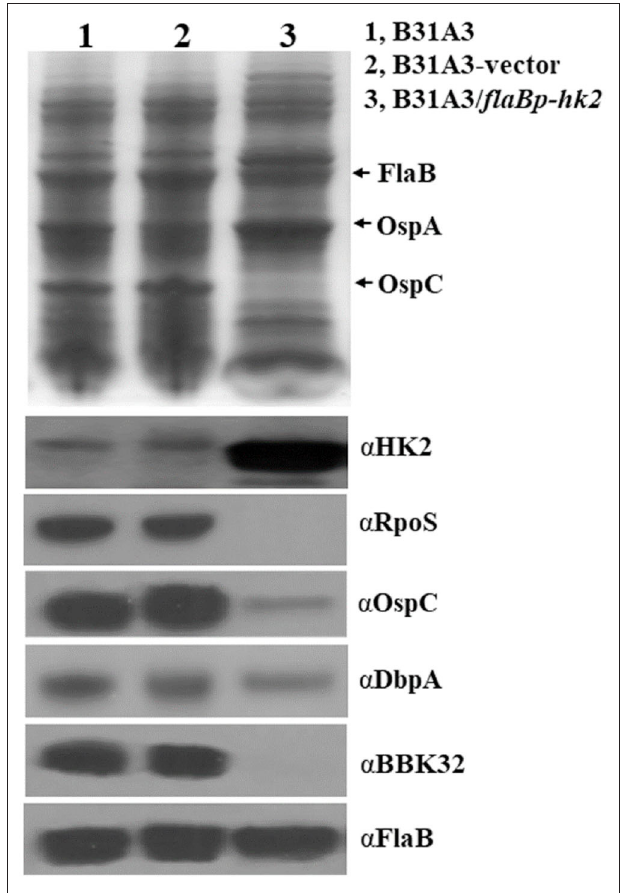
FIGURE 3 | Overexpression of HK2 impaired production of RpoS and RpoS-controlled lipoproteins. Spirochetes were cultivated in BSK-II medium at 37 ◦ C and were harvested at the stationary phase, and whole-cell lysates were subjected to SDS-PAGE (top) and Western blot analyses (bottom). The positions of proteins and antibodies used are indicated on the right. B31A3, wild-type B. burgdorferi ; B31A3-vector, B31A3 carrying an empty shuttle vector; B31A3/ flaBp -HK2, B31A3 carrying a vector harboring a hk2 gene driven by a constitutive flaB